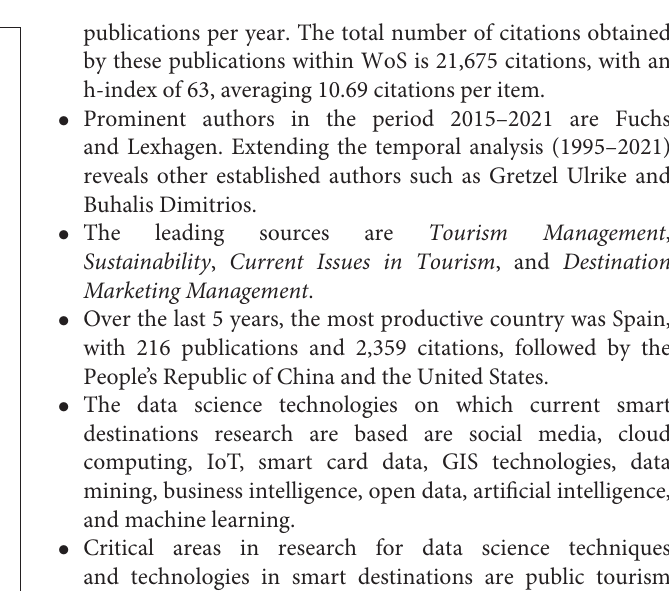
Everything related to experiences in the lower left quadrant is